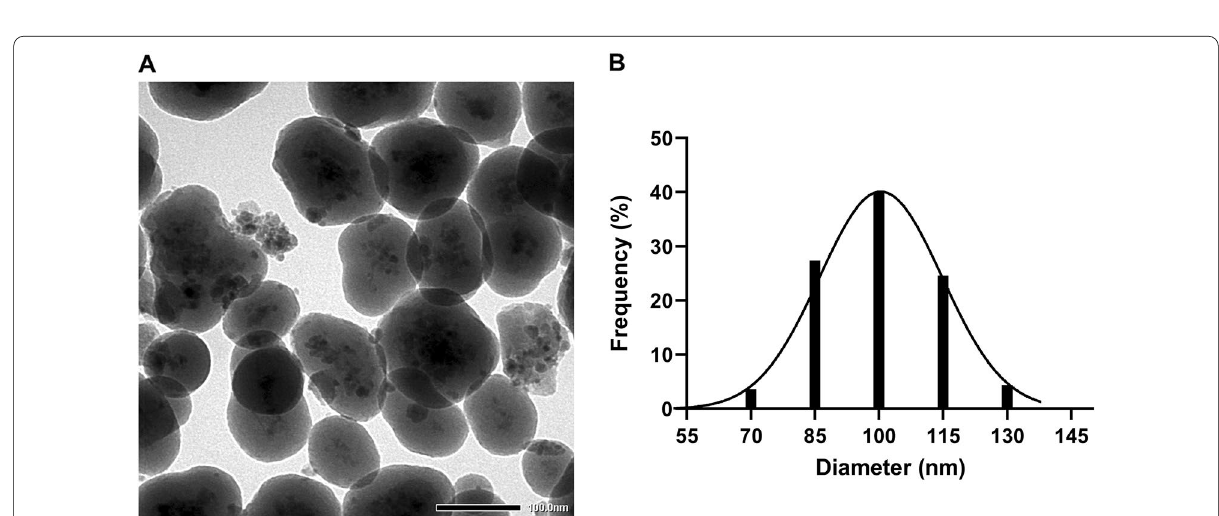
Fig. 3 Transmission electron microscopy (TEM) image and size distribution of silica‑coated magnetic nanoparticles (Fe 3 O 4 @OA@SiO 2 ). ( A ) TEM image, scale bar: 100 nm. ( B ) Size distribution, n =